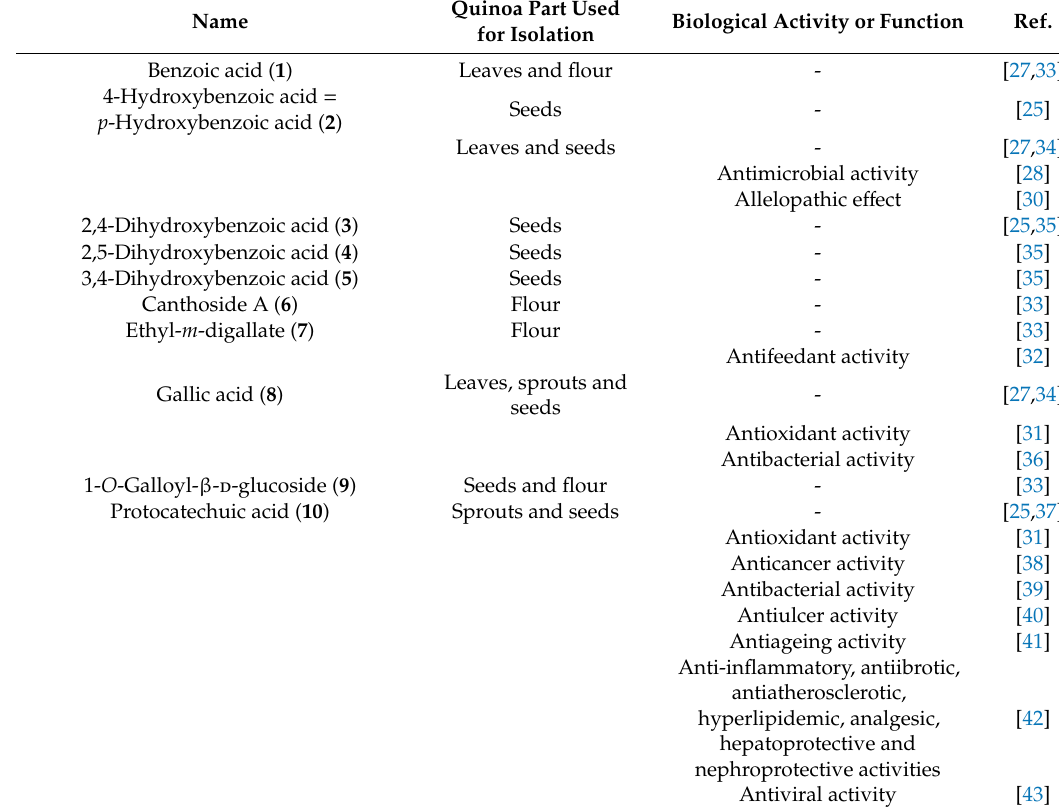
Table 1. Benzoic acid analogues and their biological activities or